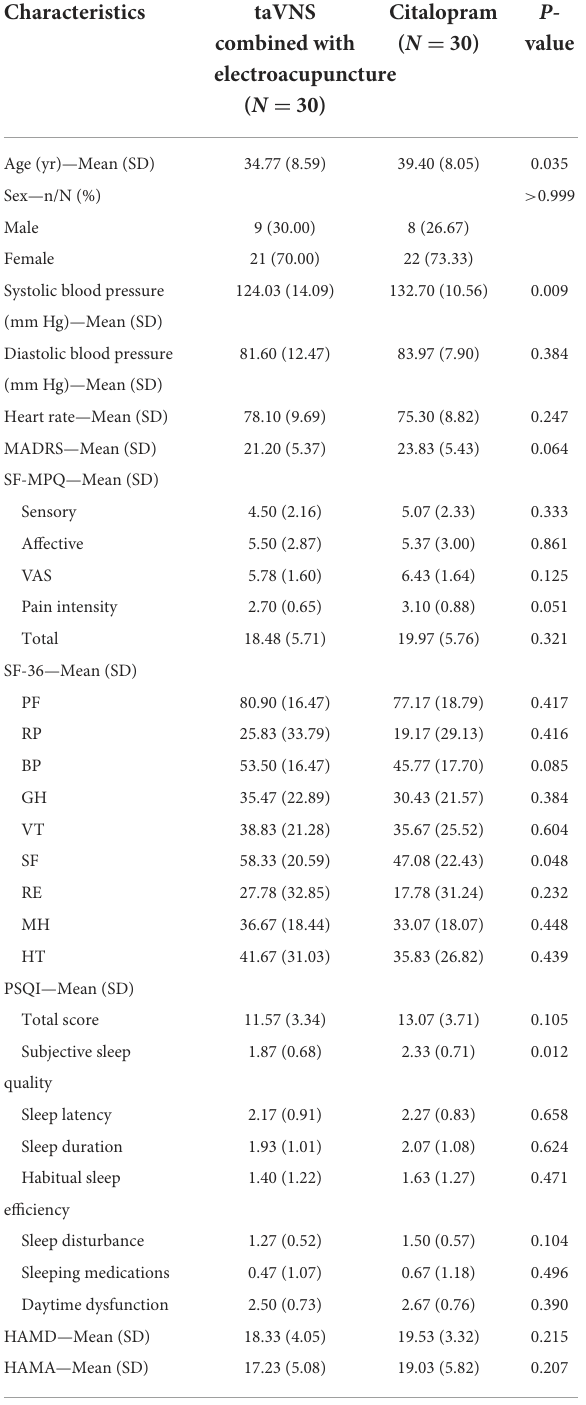
TABLE 1 Demographic and clinical characteristics of the patients at